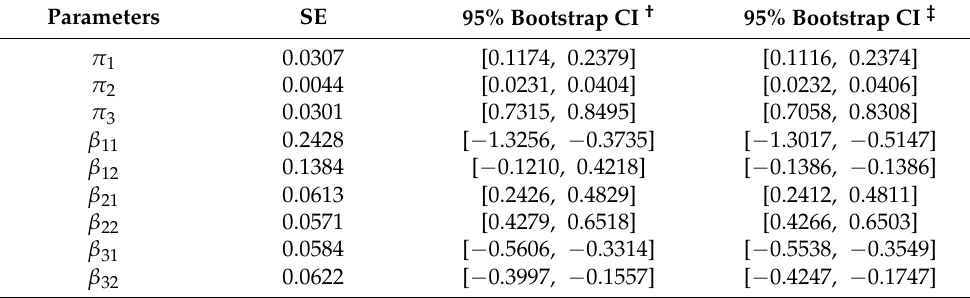
Table 8. The estimated parameters for the optimal model.